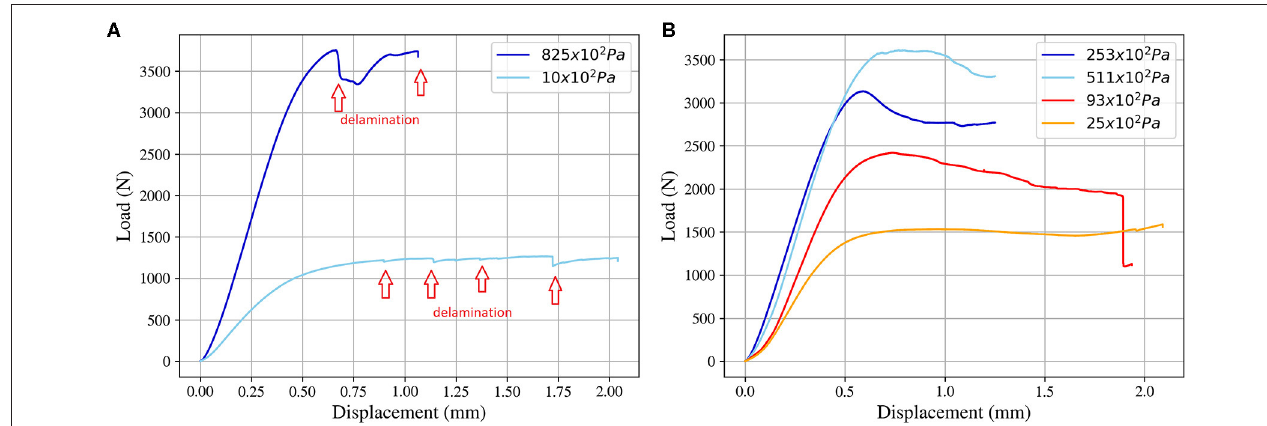
FIGURE 13 | ILSS failure profiles. (A) Failure by delamination profiles. (B) Plastic deformation profiles.